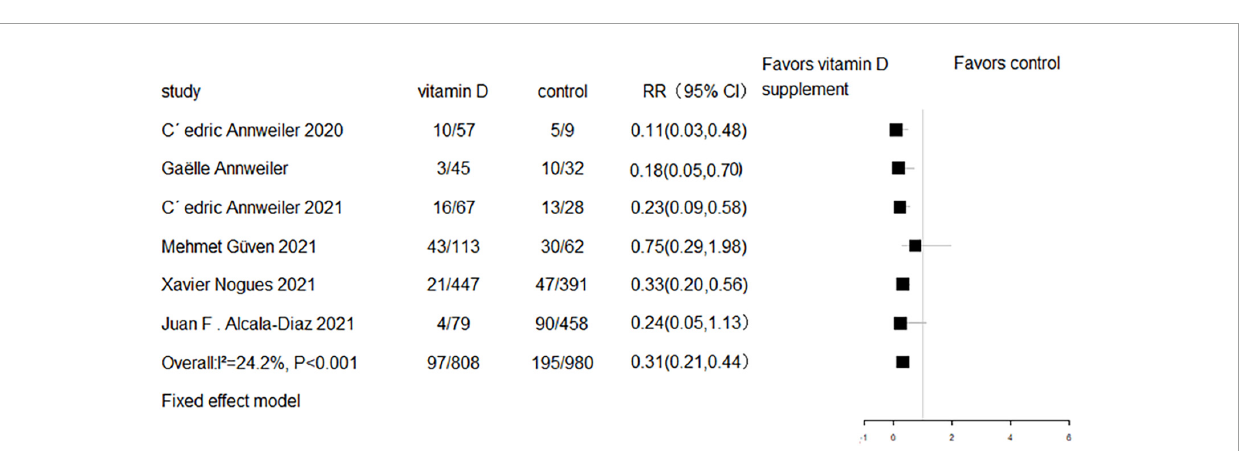
FIGURE4 Forest plot of cohort studies for vitamin D supplementation on mortality (studies with adjusted RR values only).